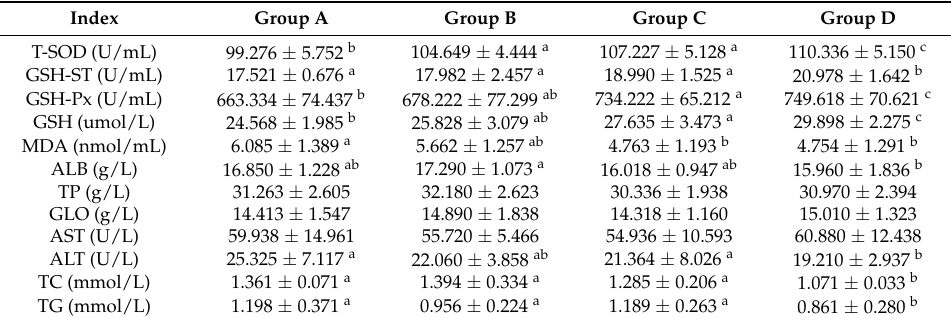
Table 3. Effect of intragastric administration with C. butyricum Sx-01, L. salivarius C-1-3 and a combination thereof on blood indices of mice.